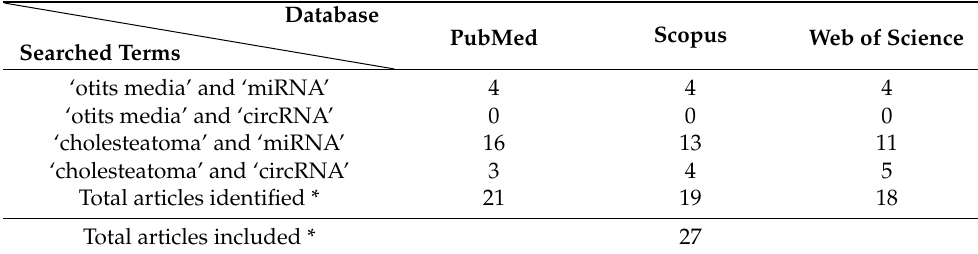
Table 1. Identification of publications meeting the inclusion criteria based on the results of searching the PubMed, Web of Science and Scopus databases.